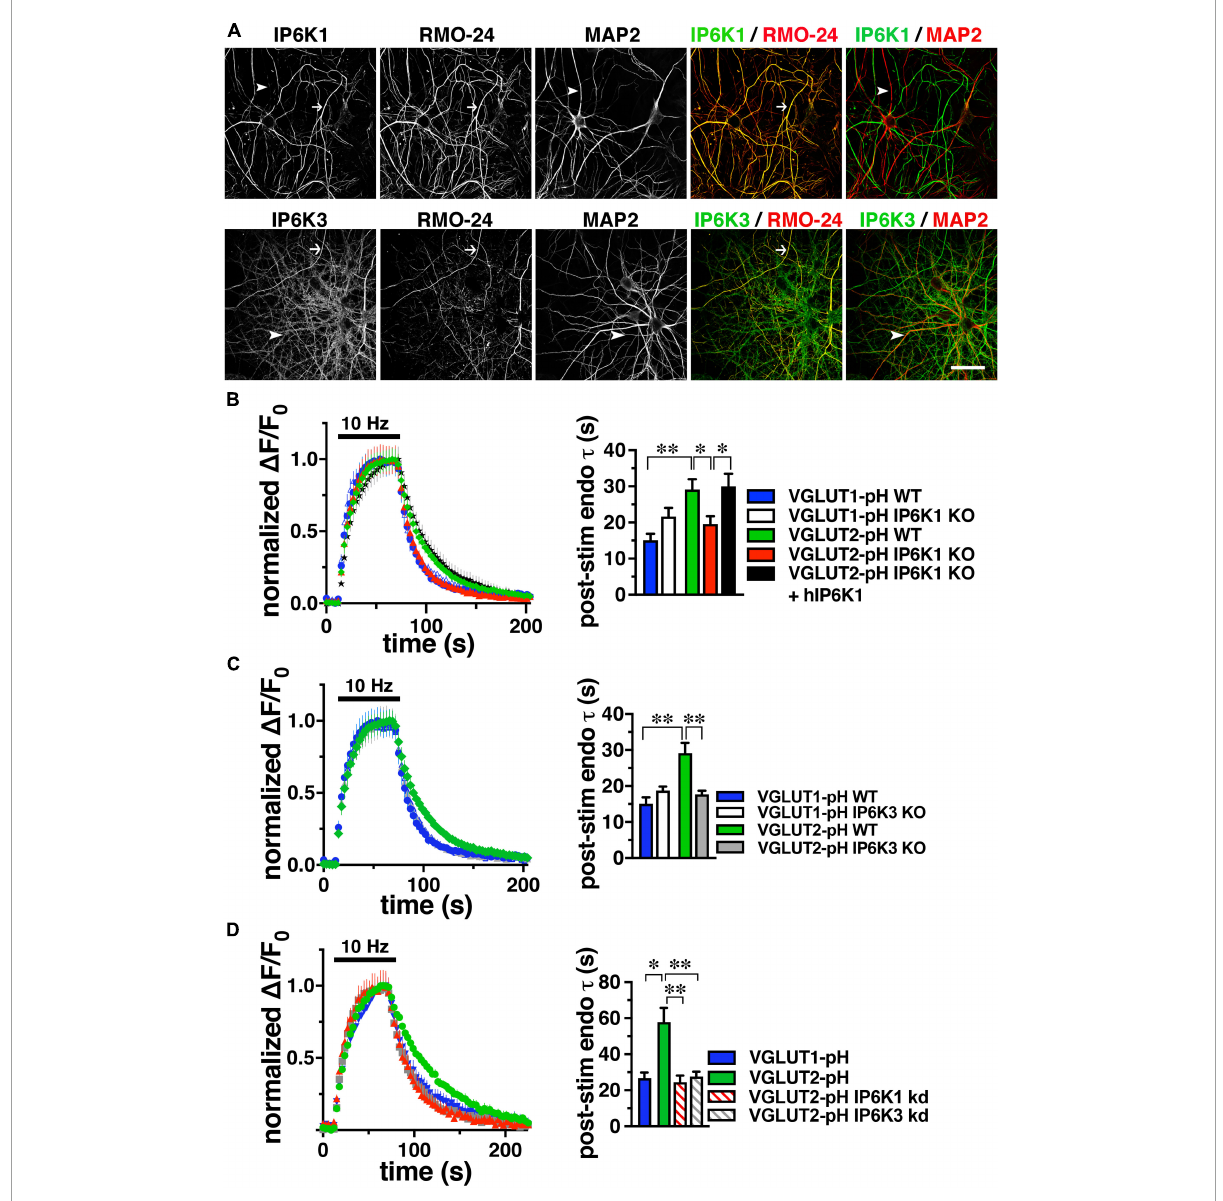
FIGURE2 IP6K1 or IP6K3 deletion accelerates VGLUT2-pH endocytosis. (A) Co-localization of endogenous IP6K1 and IP6K3 (green) in DIV14 mouse hippocampal neurons with the axonal neurofilament marker RMO-24, and the dendritic marker MAP2 (red). Arrows indicate IP6K1 and 3 colocalization with RMO-24 (yellow in merge panels). Arrowheads indicate colocalization of IP6K3, but not IP6K1, with MAP2. (B) Time course and quantification ( τ ) of normalized fluorescence changes ( (cid:49) F/F 0 ) of VGLUT-pHs in response to 10Hz 60 s stimulation in WT and IP6K1 KO neurons. (C) Fluorescence changes of VGLUT-pHs in WT and IP6K3 KO neurons. (D) Fluorescence changes in neurons transfected with VGLUT2-pH and infected with lentivirus containing empty vector or shRNA to IP6K1 or IP6K3. Data are means ± SEM from at least 35